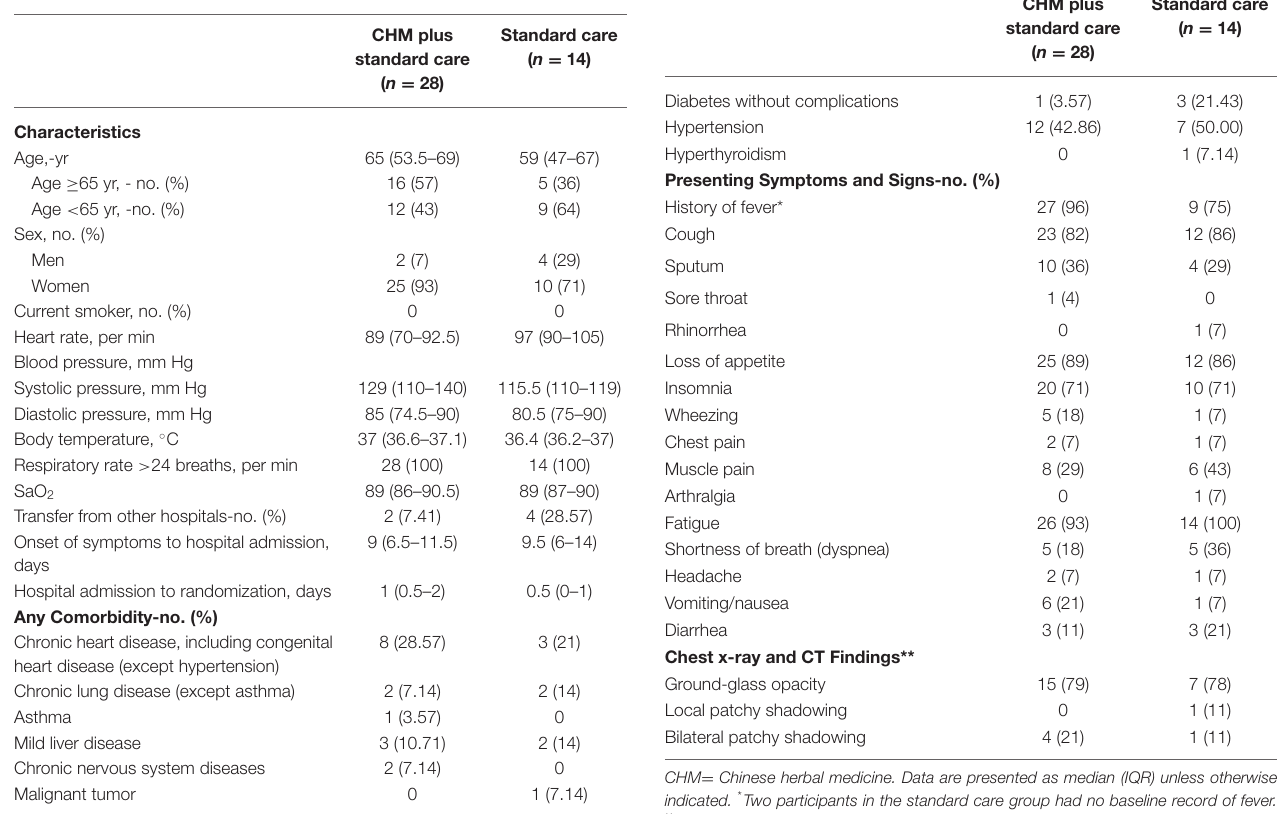
TABLE 1 | Baseline demographic and clinical characteristics of the trial